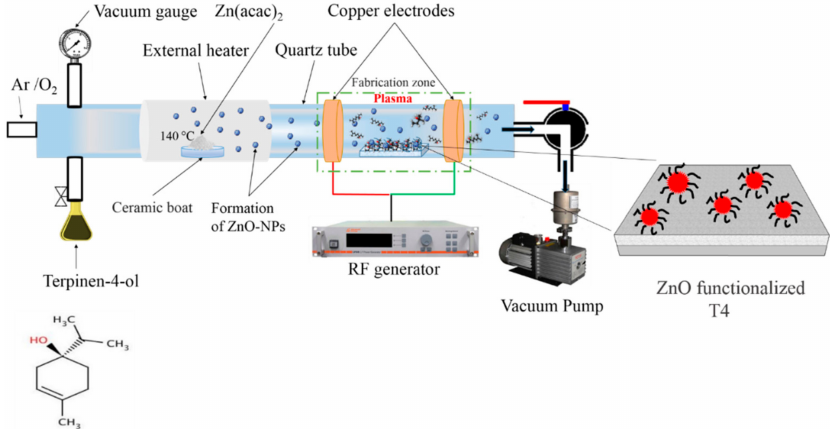
Figure 1. Schematic of plasma polymerization apparatus